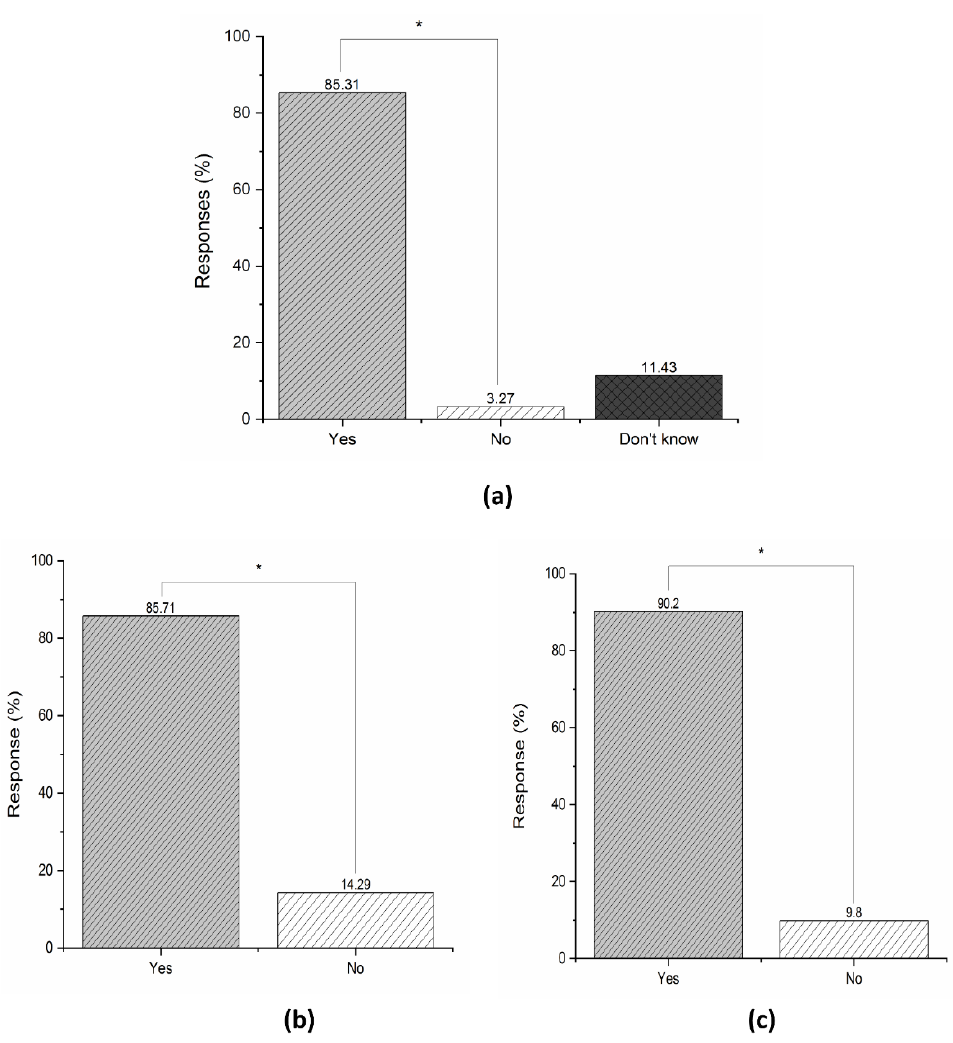
Figure 5. Responses of professionals to the following survey questions: ( a ) Do you consider sodium hypochlorite to be a good disinfectant? ( b ) Did you know that sodium hypochlorite (0.10% to 0.50%) is effective for the inactivation of the new coronavirus and is recommended by the World Health Organization (WHO) for the disinfection of home and hospital environments? ( c ) Did you know that the disinfectant solution used in the chamber for the instantaneous disinfection of personal protective equipment (PPE) is sodium hypochlorite solution? * represents p < 0.05 by Friedman test with Dunn’s multiple comparisons test.